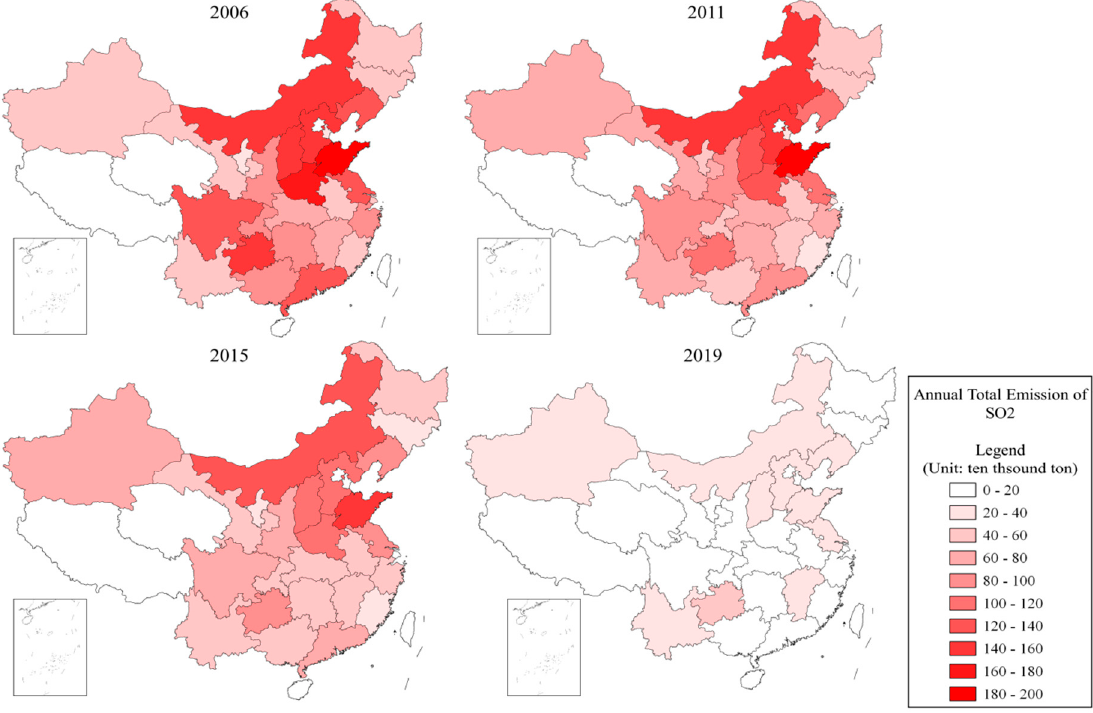
Figure 6. Distribution of SO 2 in Chinese provinces from 2006 to F igure 6. Distribution of SO 2 in Chinese provinces from 2006 to 2019.